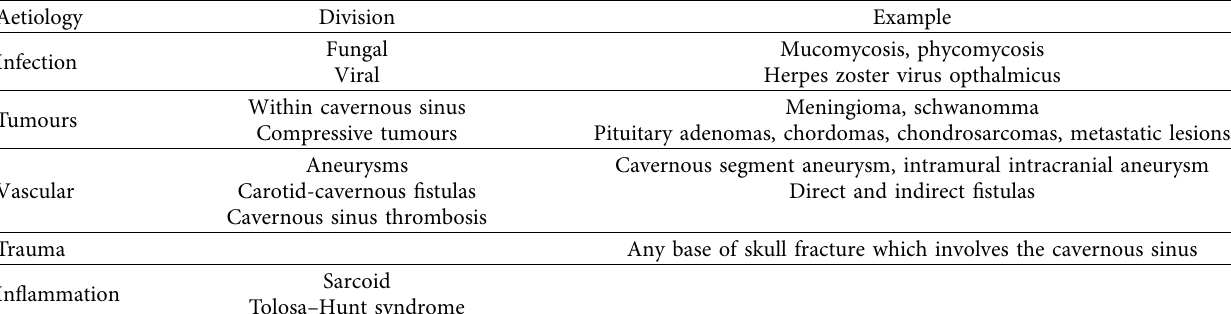
Figure 1: T1-weighted postcontrast MRI brain showing abnormal enhancement of the left cavernous sinus (arrows) in the axial and coronal views, respectively. Table 1: Different aetiologies of cavernous sinus